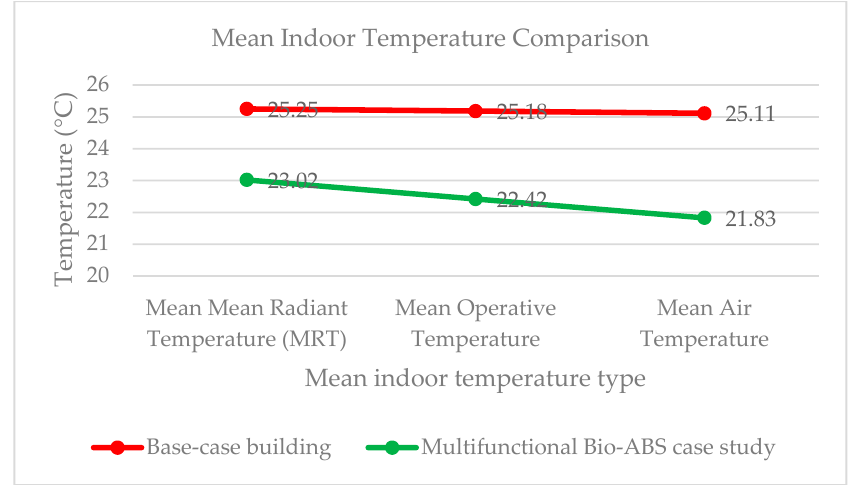
Figure 19. Mean indoor temperature comparison between the base ‐ case building, and the case study.